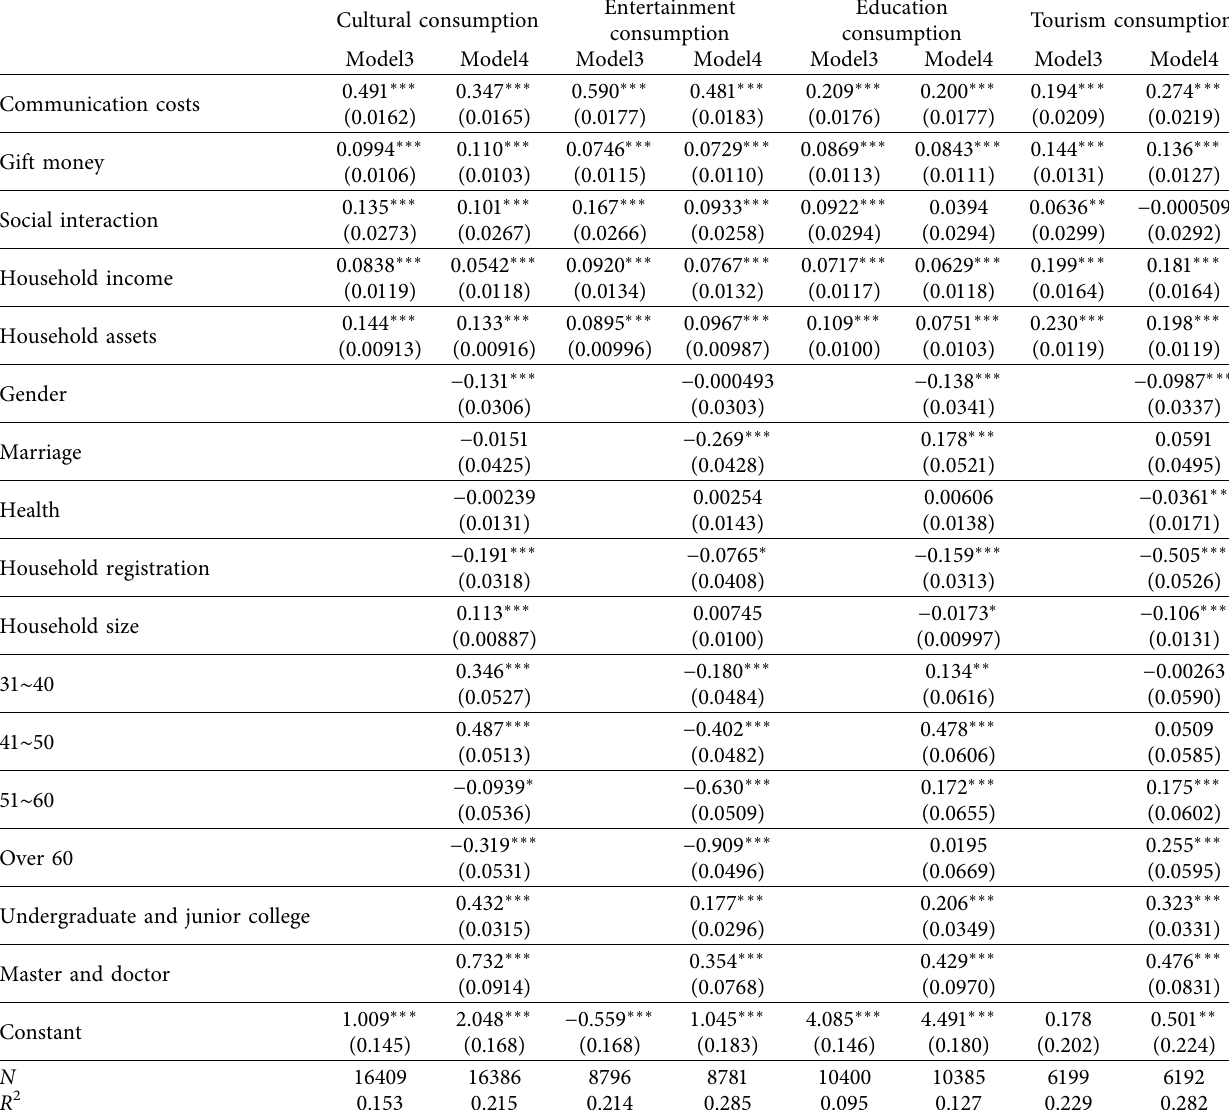
Table 3: Impact of householder’s individual characteristics on cultural consumption under the influence of social